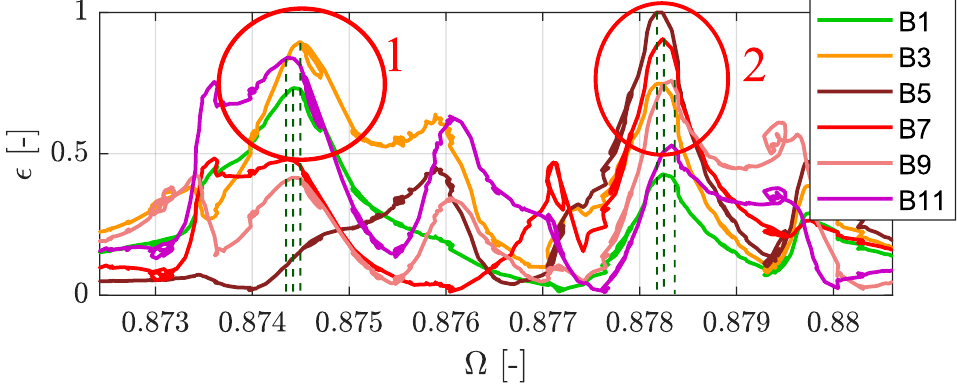
Figure 5. Normalized strain over normalized rotational speed during M8 excitation for all SG-applied blades.